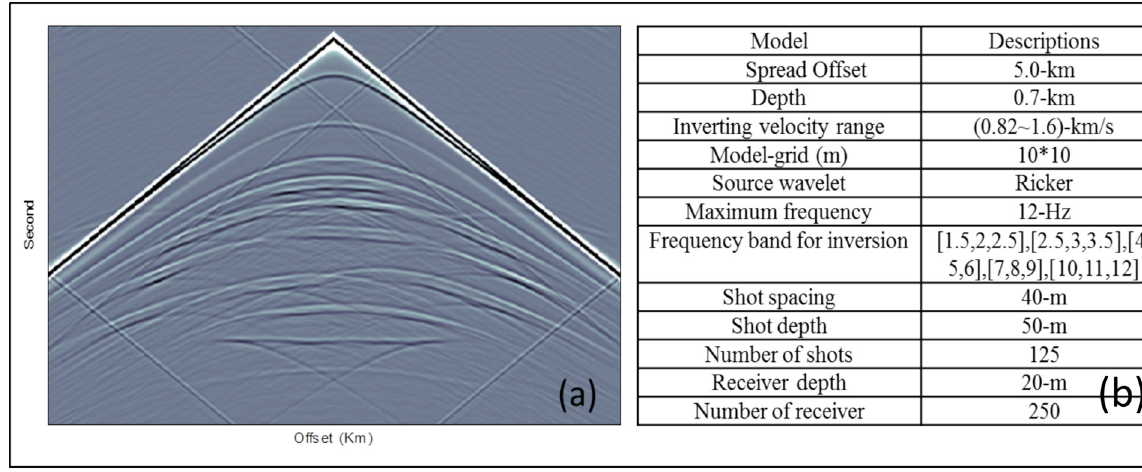
Figure 4. (a) Shot gather time-domain seismic data; (b) model descriptions used for modeling and